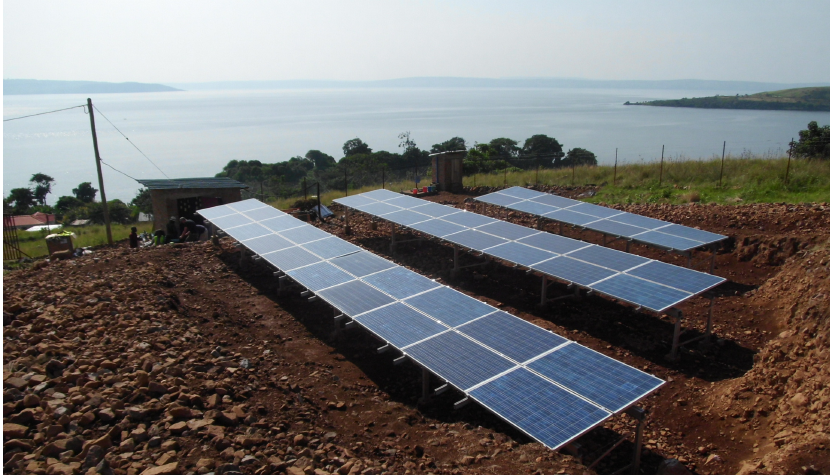
Figure 5. System overview picture with photovoltaic installation in the foreground and the battery powerhouse on the left. For the solar modules, the area was leveled out to achieve good alignment. The visible power pole represents the connection point to the external stand-alone grid. For security reasons, the property is fenced in. This kind of project in the vicinity of water bodies also requires sanitary facilities, which can be recognized in the center of the picture. In the distant background with a view to the west, the mainland is already noticeable.